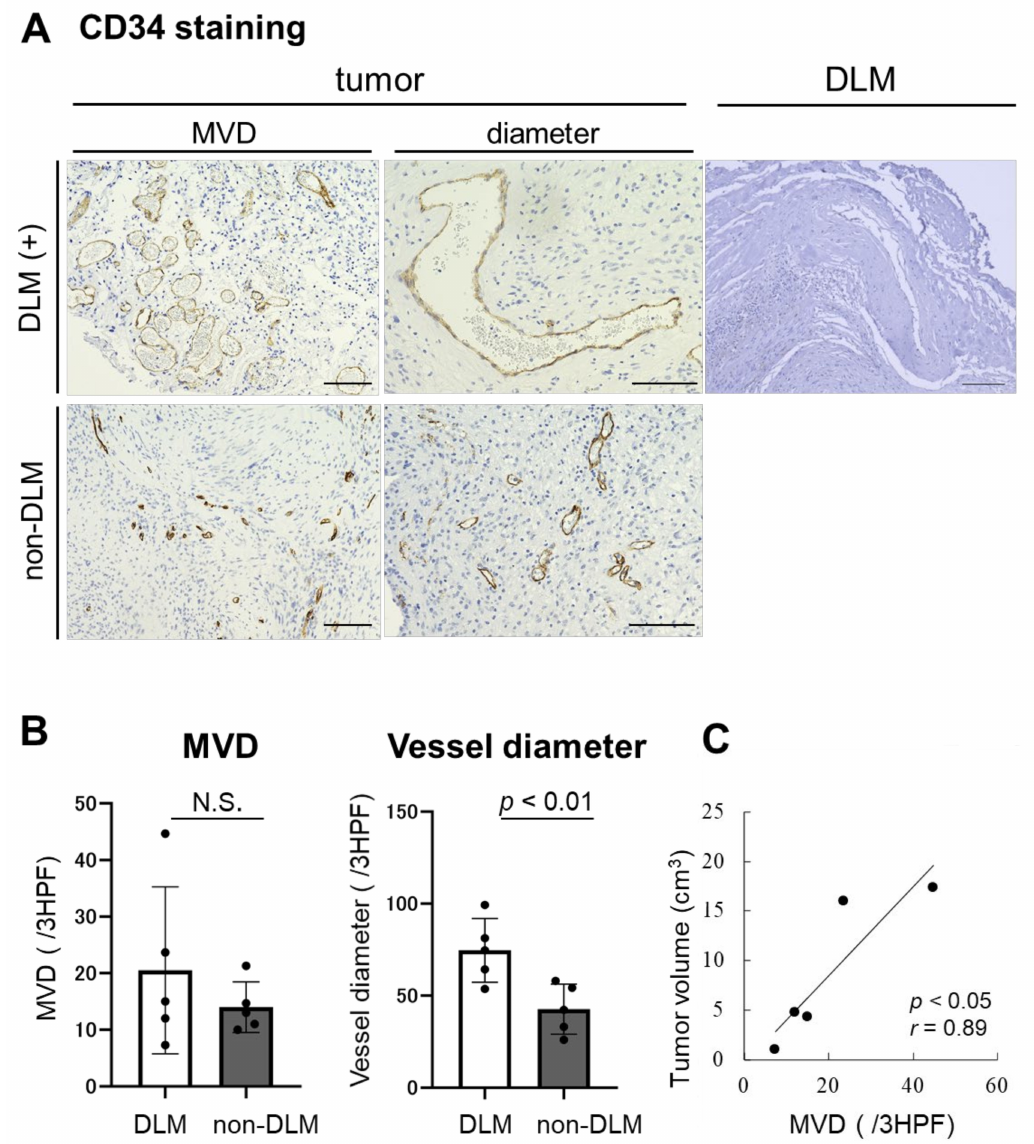
Figure 3. Immunohistopathological analysis of CD34 staining. ( A ) Microvessel density (MVD) and diameter analyzed using CD34 staining are shown. Large CD34(+) vessels are observed in the tumors with DLM. Few CD34(+) vessels are identified in DLM (scale bar= 100 µ m). ( B ) No significant difference is observed in the MVD in the tumors between DLM group and non-DLM groups ( p = 0.19). Vessel diameters are significantly larger in DLM group than that in non-DLM group ( p < 0.01). ( C ) The correlation between tumor volume and MVD are shown. The larger-sized VSs demonstrate higher MVD in the tumor with DLM ( p < 0.05, r =